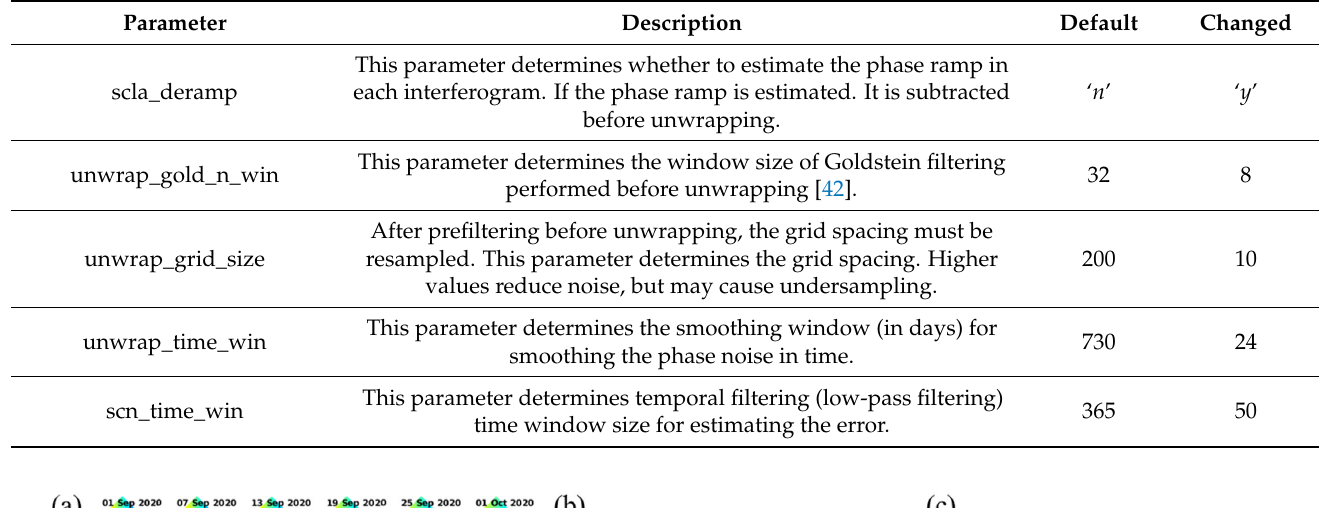
Table 3. Changed StaMPS package parameters in this study (modified from Matthias Schlögl [47]).